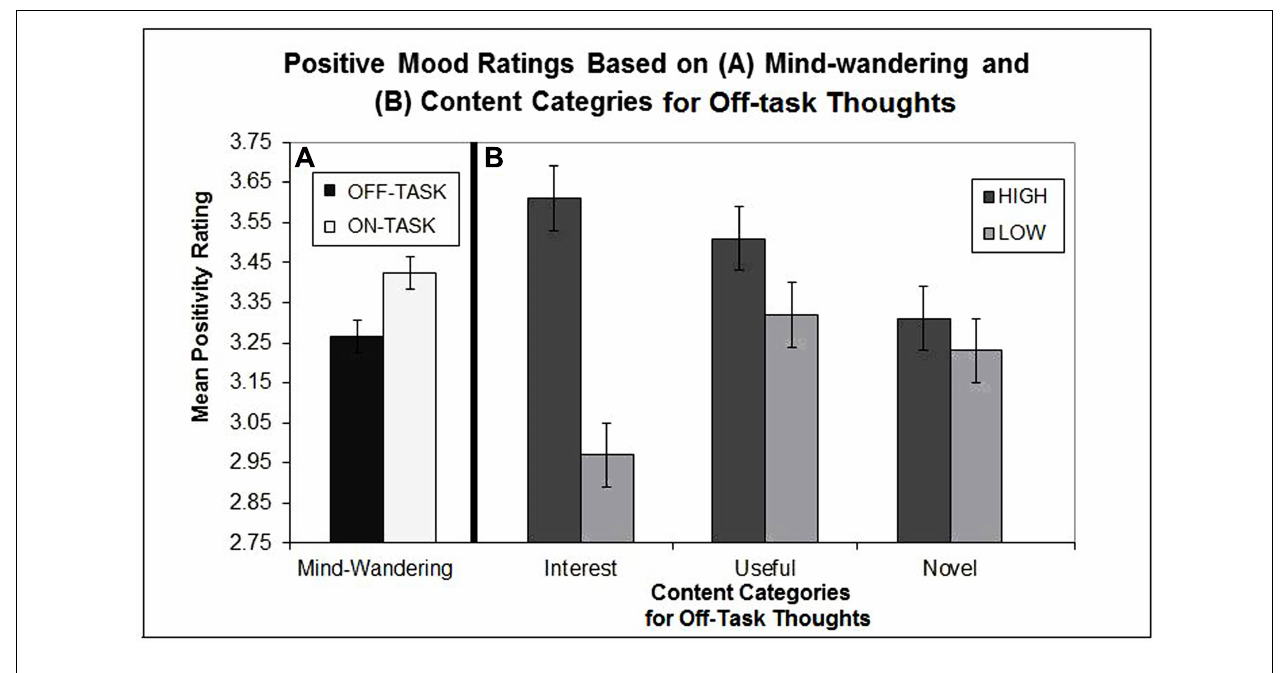
FIGURE 1 | (A) Displays the mean positive mood ratings based on whether participants reported being on- vs. off-task for a given probe and (B) displays the mean positive mood ratings for off-task reports based on the three